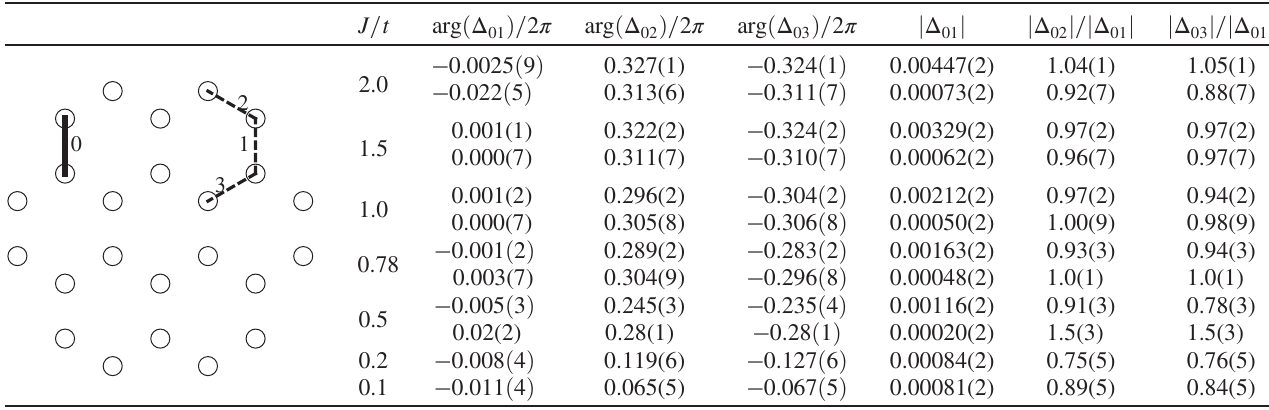
TABLE III. Pair-pair correlation function in t - J model on 24-site sample, comparing DMRG ground state projected into the exp ð − i 2 π = 3 Þ eigenspace of C 6 rotation (top values) to VMC result on d þ id variational wave function (bottom values) in each row. Last ˆ B ˆ B † two rows are DMRG only. The correlation function Δ is considered for nearest-neighbor bond b ¼ ij (labeled 0 in the bb 0 ¼ h kl i ij figure) and nearest-neighbor bond b 0 ¼ kl being one of b 0 ¼ 1 , 2, 3. To reduce statistical error, the presented value for any of these bond pairs bb 0 is obtained by averaging over all bond pairs related by translation